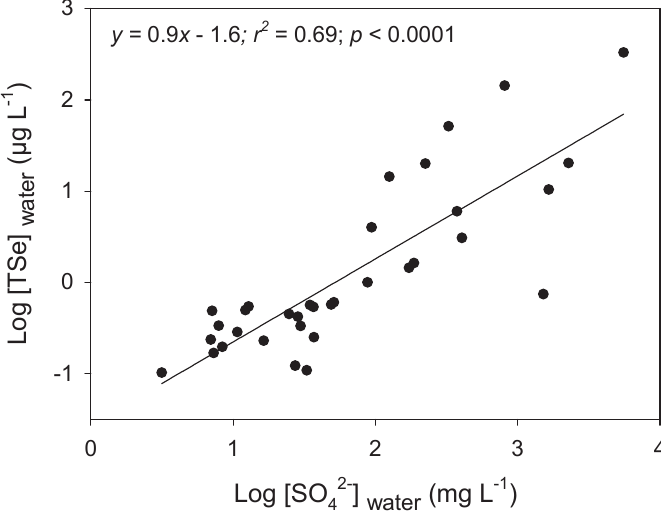
Figure 6. Log-transformed total dissolved Se concentrations (Log [TSe] water ; μ g L -1 ) as a function of log-transformed sulfate concentrations (Log [SO 42- ] water ; mg L -1 ) for boreal lakes in mining regions (Ponton and Hare [46]), coal operations-contaminated sites [50,65,66], and in Kesterson Reservoir [56].